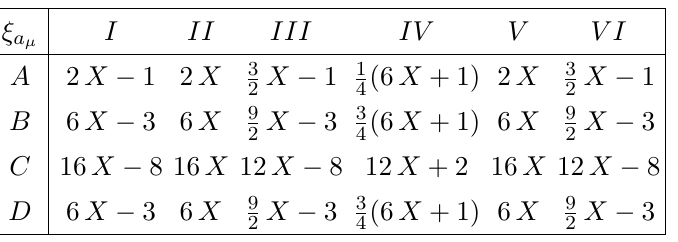
Table 4 . Group factors for the various representations entering the anomalous magnetic moment of the